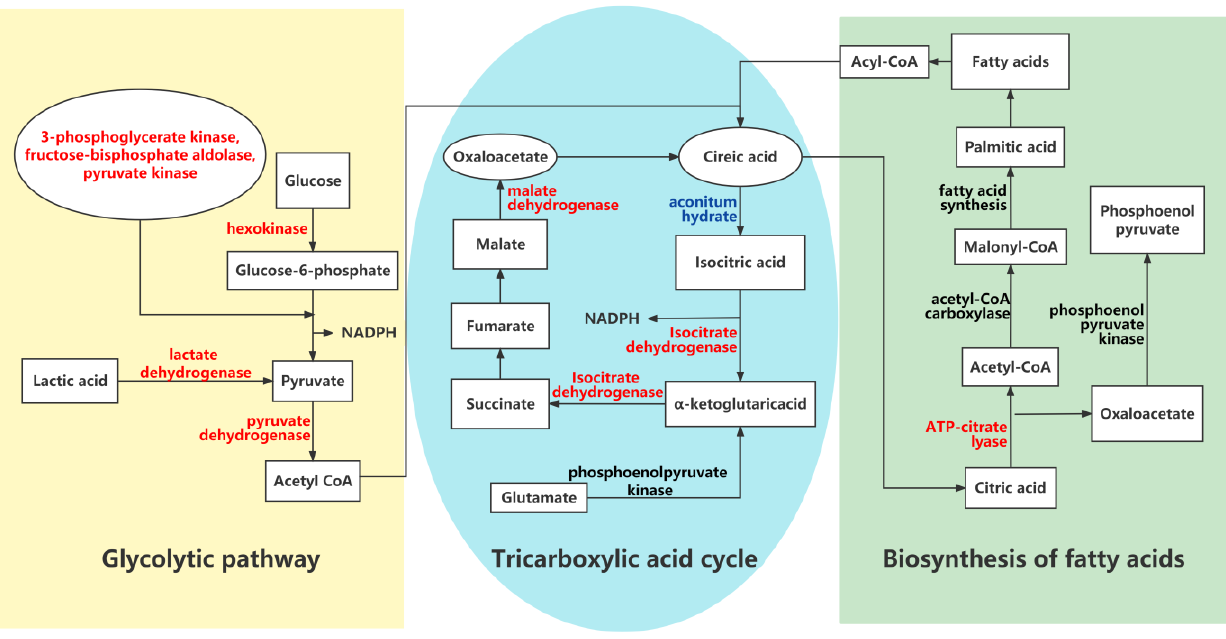
Figure 13. Acetyl-CoA and NADPH metabolism involved in the glycolytic pathway, the tricarboxylic acid (TCA) cycle, and the biosynthesis of fatty acids. The up-regulated and down-regulated enzymes are highlighted in red and blue, respectively.